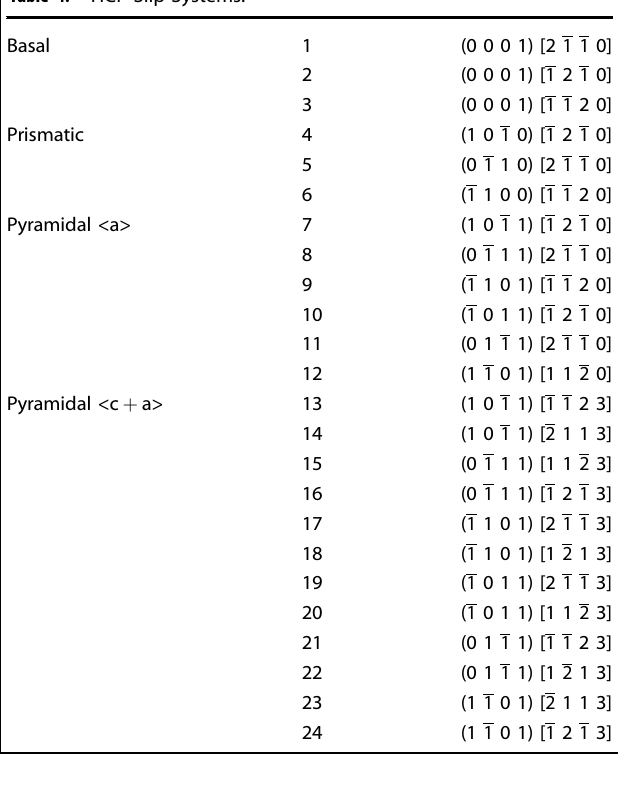
Table 4. HCP Slip Systems.